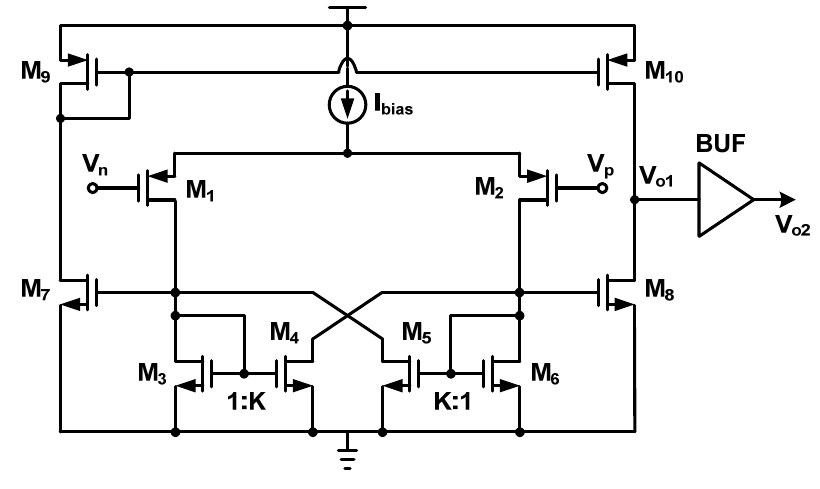
Figure 6. Conventional hysteresis comparator.